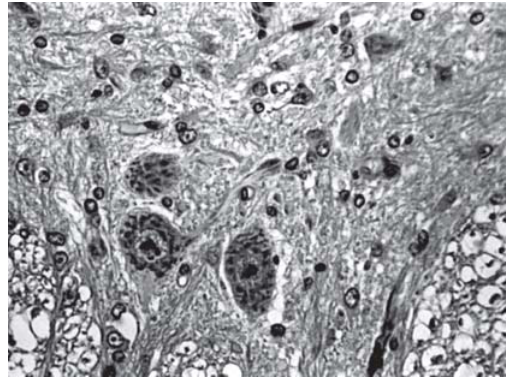
Fig. 4 - Sections from spinal cords of animals in the sham operations